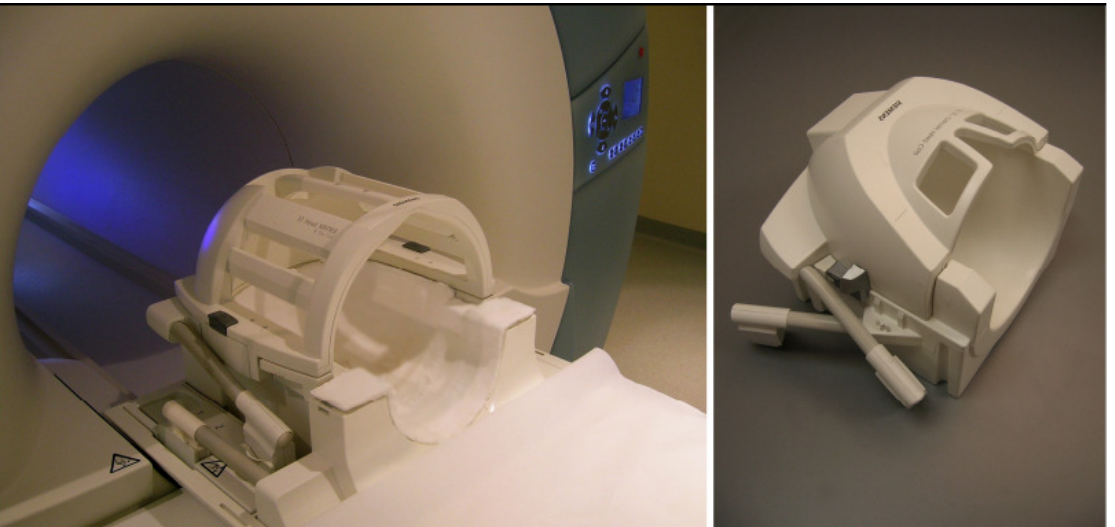
gradient coils 0